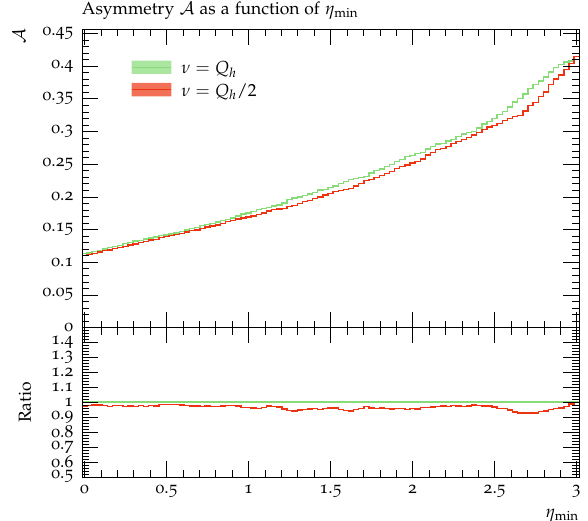
Figure 20 . Asymmetry